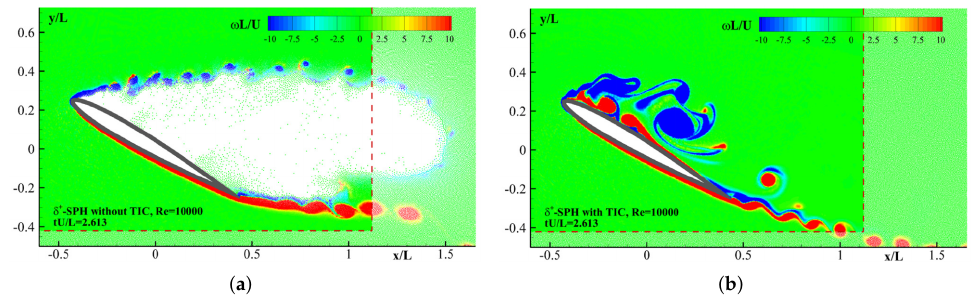
Figure 11. Direct SPH simulation of viscous flow around a foil at Re = 10,000 without ( a ) and with ( b ) TIC. The flow void is induced when TIC is not used. For more details regarding the simulation configurations, the readers can refer to